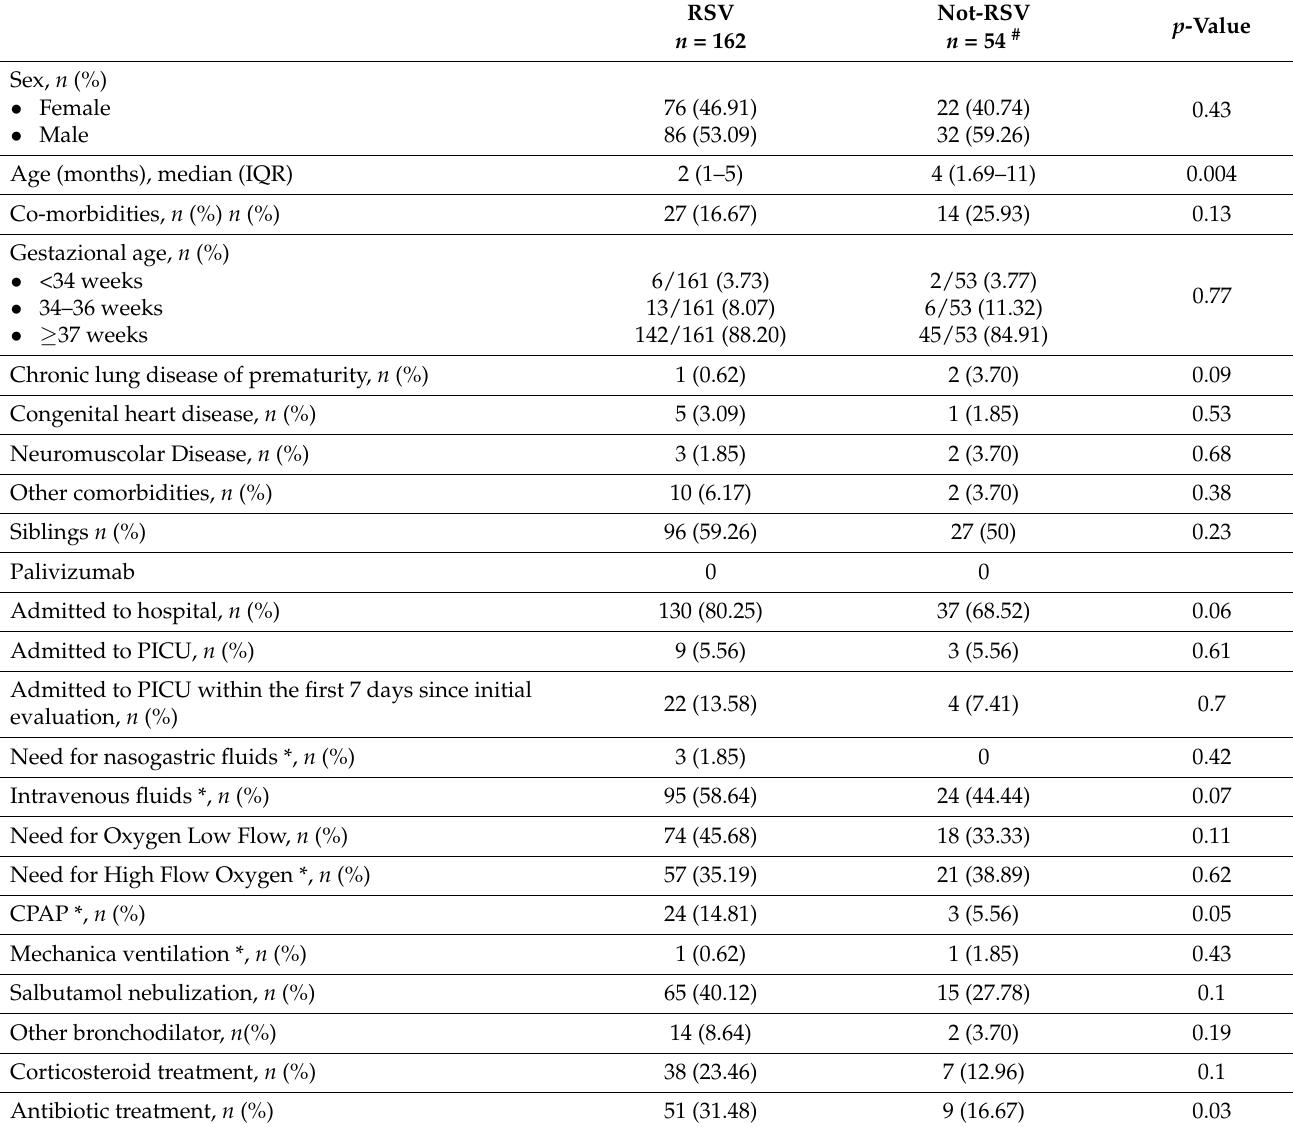
Table 3. Disease severity according to main etiological group. CPAP, continuous positive